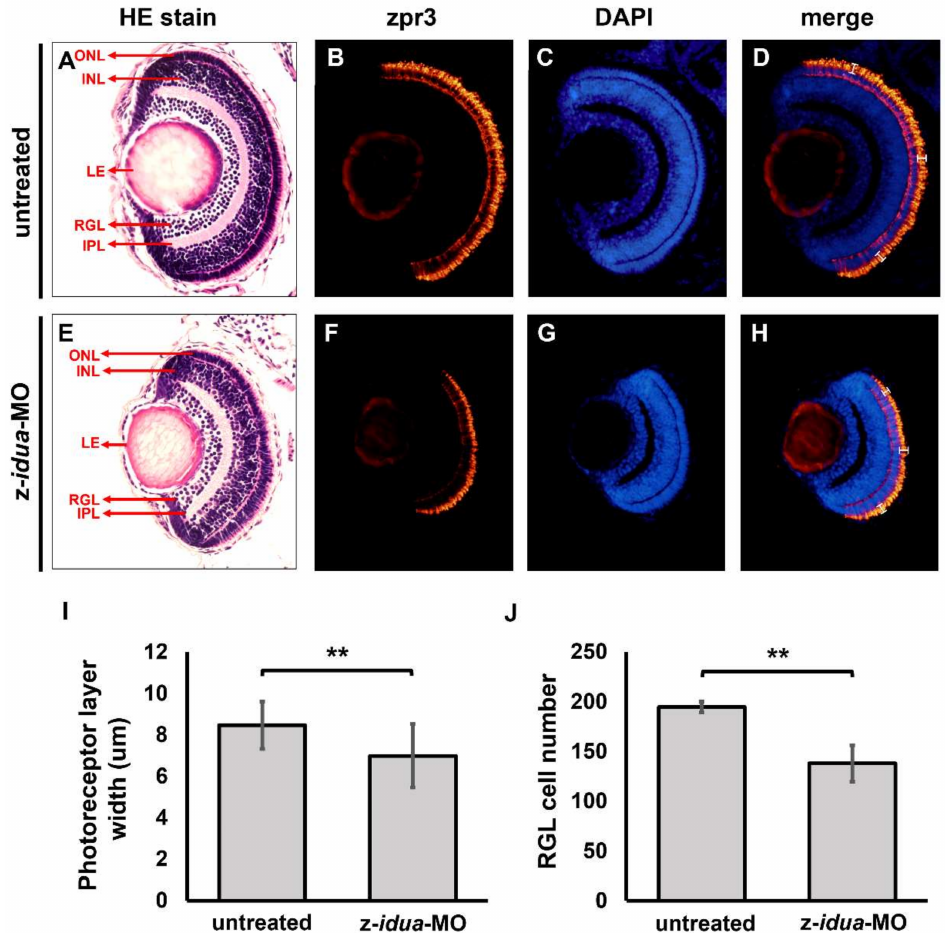
Figure 5. Knockdown of z- idua caused defective eyes in zebrafish embryos. Using hematoxylin and eosin staining (HE stain) and immunofluorescent staining to examine the ocular morphology of zebrafish embryos at 120 hpf. ( A – D ) untreated control groups; ( E – H ) z- idua -knockdown embryos. ( A , E ) HE staining; ( B , F ) immunofluorescent stain using zpr3 antibody to detect rod cells labeled in red fluorescence; ( C , G ) DAPI-marked nucleus labeled in blue fluorescence; ( D , H ) two signals merged. ( I ) To quantify the width of photoreceptor layer. ( J ) To quantify the cell number in retinal ganglion layer (RGL). All data were averaged from five independent experiments and represented as mean ± S.D. Student’s t -test was used to determine significant differences between each group (**, p < 0.01). ONL, outer nuclear layer; INL, inner nuclear layer; LE, lens; RGL, retinal ganglion layer; IPL, inner plexiform